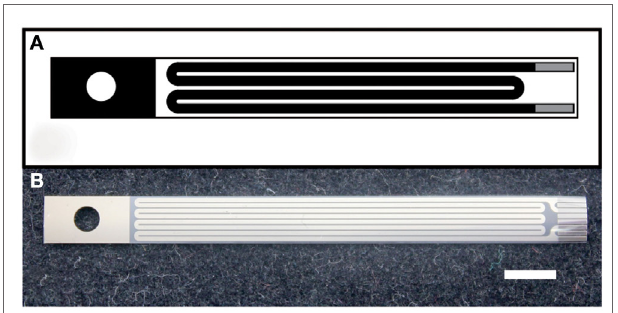
FigUre 2 | (a) Cartoon and (B) photograph of minimum bending diameter test devices (scale bar is 5 mm). In cartoon (a) , the thickness of the traces has been increased and number of turns decreased for illustrative purposes. The metal and hole on the left side of device are for clamping the device to the testing fixture. The contact pads on the right side allow electrical resistance